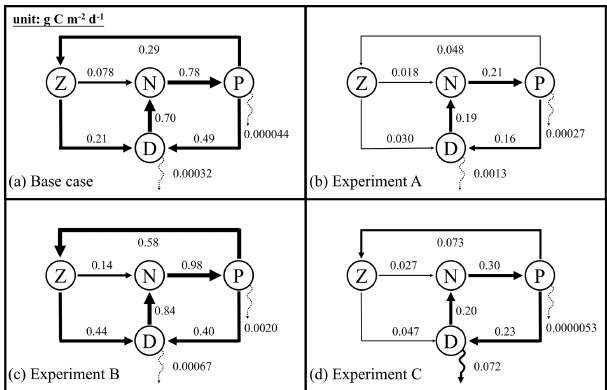
Figure 6. Annually averaged carbon fluxes integrated over the up- per 200m (unit: gCm − 2 d − 1 ) for the base case (a) and optimized experiments A, B, and C. The N, P, Z, and D stand for the pools of nutrient, phytoplankton, zooplankton, and the sum of small and large detritus, respectively. The thickness of arrows scales with the magnitude of fluxes. Dashed arrows represent fluxes lower than 0.01gCm − 2 d − 1 .